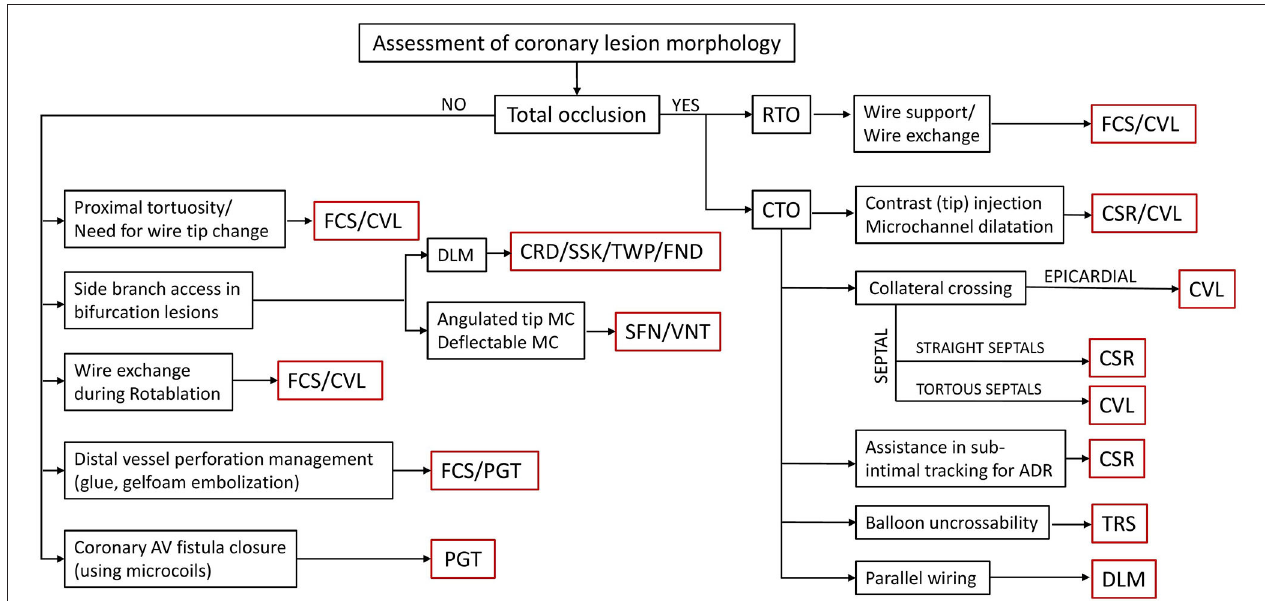
FIGURE 3 | An algorithm for the selection of a microcatheter depending on the lesion characteristics and functional requirement for that particular coronary anatomy. MC, microcatheter; RTO, recent total occlusion; CTO, chronic total occlusion; FCS, Finecross; CVL, Caravel; CSR, Corsair; TRS, Tornus; DLM, dual-lumen microcatheter; CRD, Crusade; SSK, Sasuke; TWP, Twinpass; FND, Fineduo; SFN, SwiftNinja; VNT, Venture; PGT,